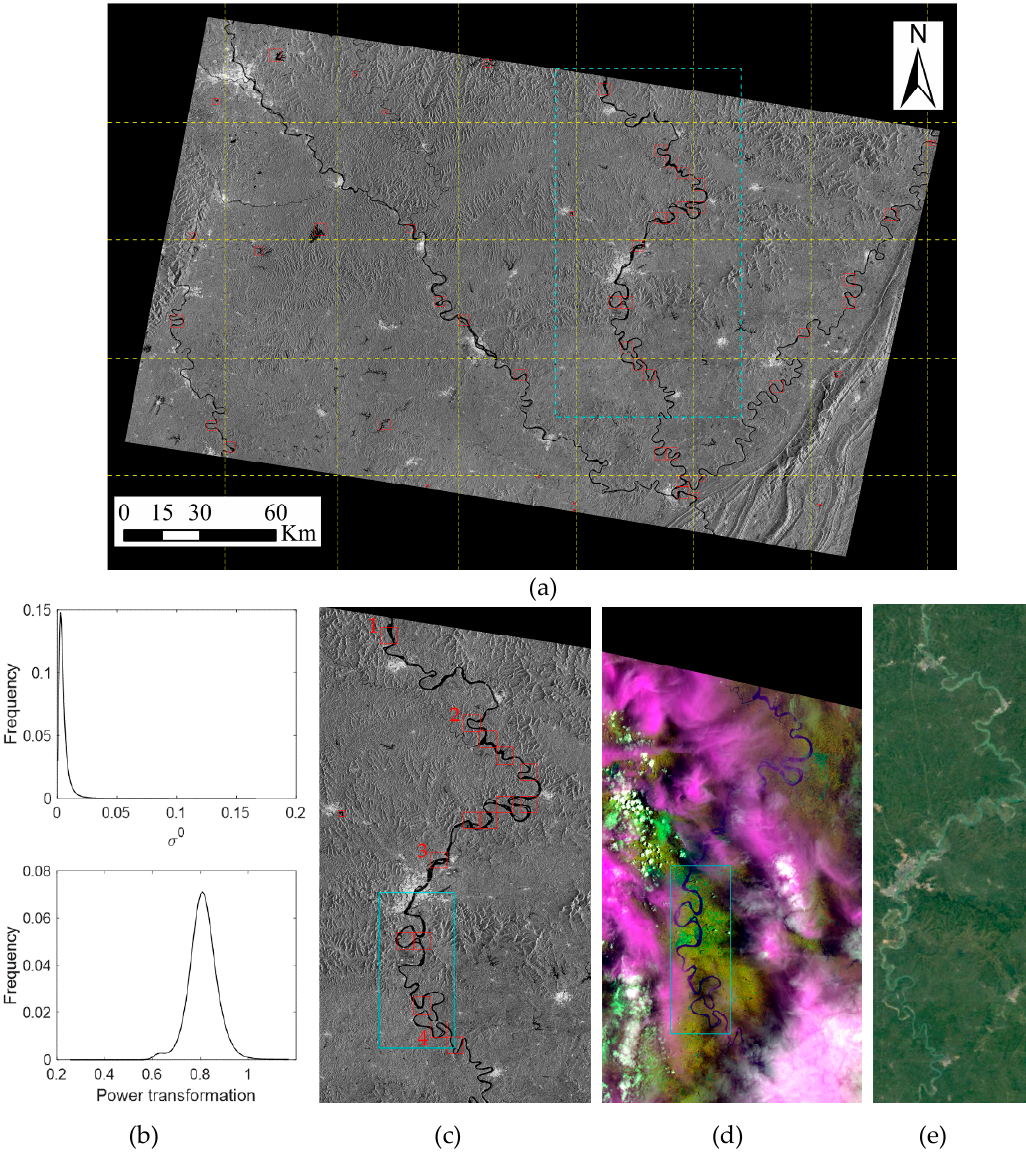
Figure 3. ( a ) Sentinel-1 VV polarized image (with size of 23969 × 36267) of the study area (15 July 2018) with the target regions in red boxes; ( b ) histograms of sigma naught value of full SAR image and the power-transformed image, from top to bottom; ( c ) the zoomed image corresponding to the cyan dotted box in ( a ); ( d ) Landsat-8 OLI / TIRS image (RGB: 5-6-4) of Jialing River (16 July 2018); ( e ) corresponding Google Earth map.